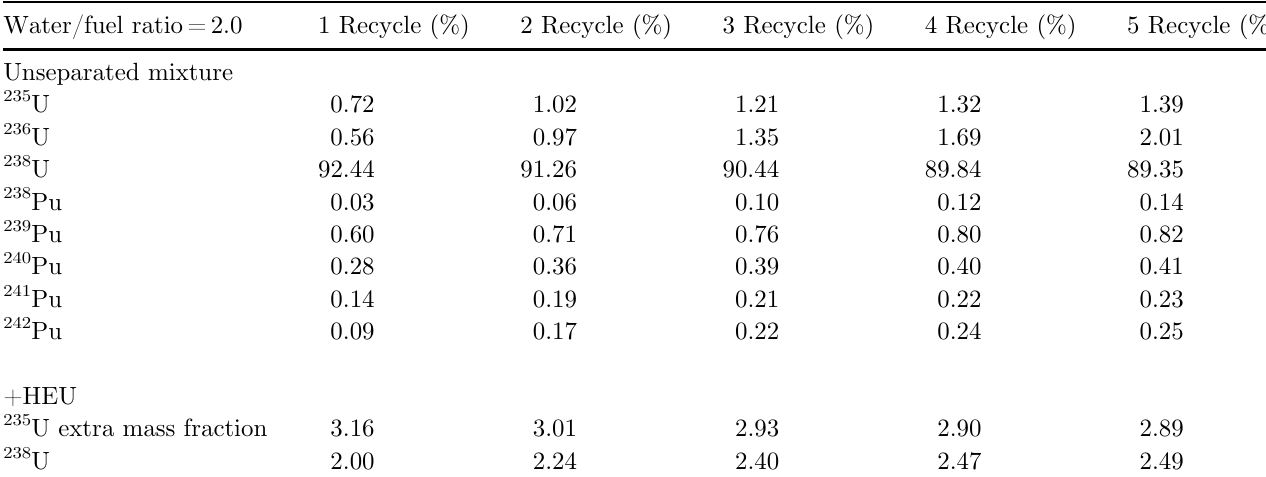
Table 2. REMIX fuel composition for FA with water/fuel ratio = 2.0. Water/fuel ratio = 2.0